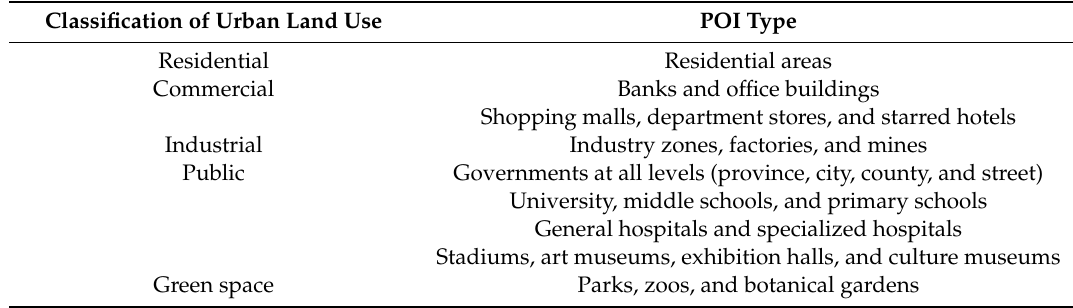
Table 1. Reclassification of the point of interest (POI)